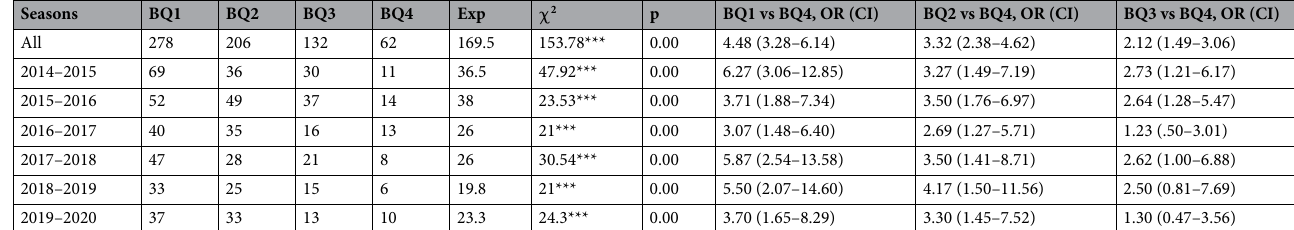
Table 2. RAE frequency for each comparison by birth quarters (BQ1, BQ2, BQ3, BQ4), with odds ratio (OR) and 95% confidence intervals (CI). ***p <